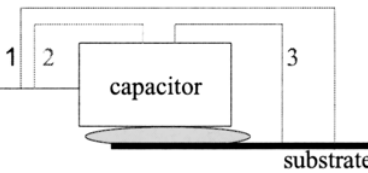
FIGURE 1 Schematic drawing of ESR measurements on a capacitor bonded on the substrate with a conductive adhesive. (1) form anode wire to substrate, (2) from anode wire to Ag coating, (3) from Ag coating to